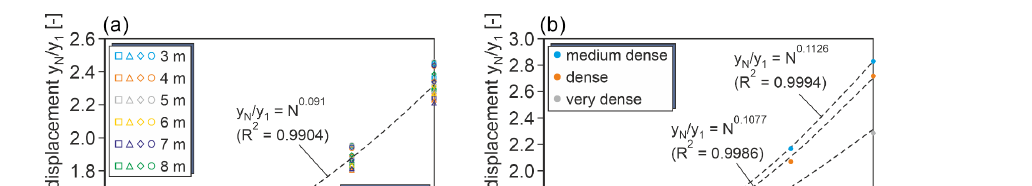
Figure 6. y multipliers for a monopile D = 5m, L = 25m in very dense sand.